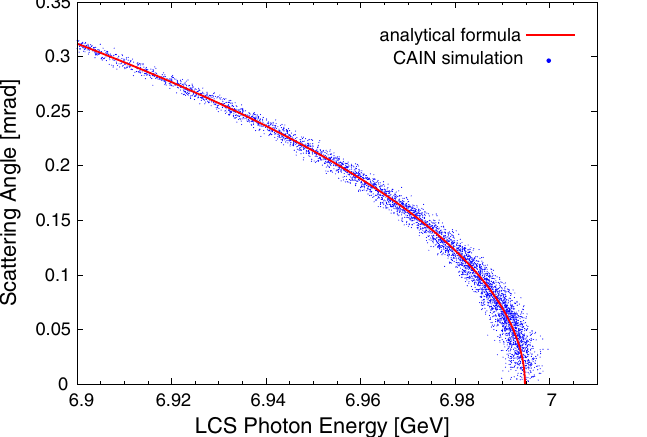
FIG. 6. γ -ray spectra of the four-mirror 7-GeV XFELO- γ calculated by an analytical formula without electron energy spread (green) and with energy spread (red), and numerical simulation by CAIN